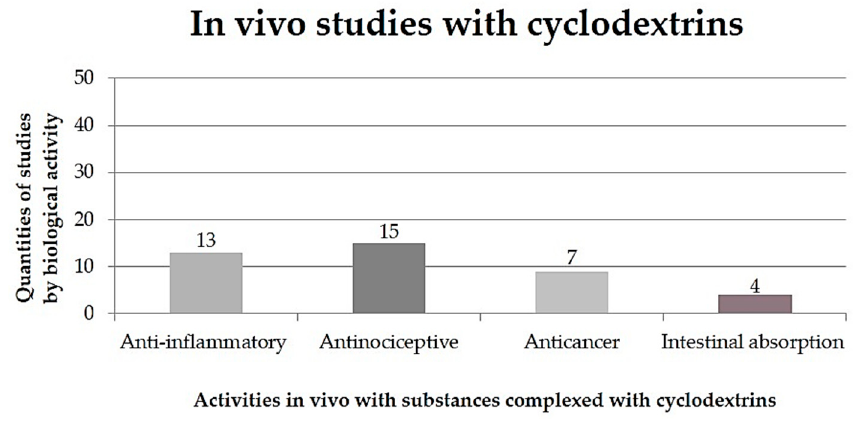
Figure 2. Quantities of in vivo studies performed with substances in an inclusion complex with cyclodextrins, according to works published in the literature in the years 2001 to 2019.